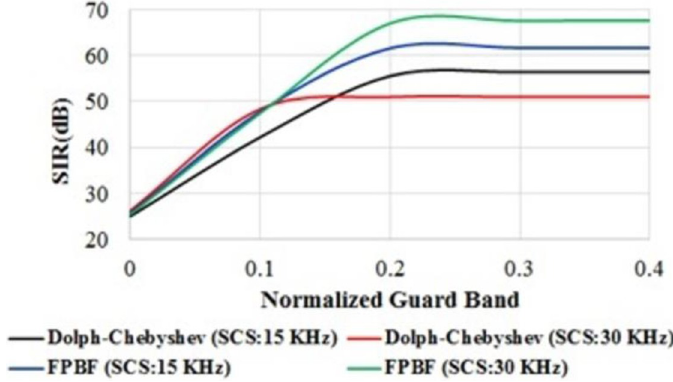
Fig 12. PSD of UFMC for two different sub-carrier spacing with FPBF and Chebyshev filter.